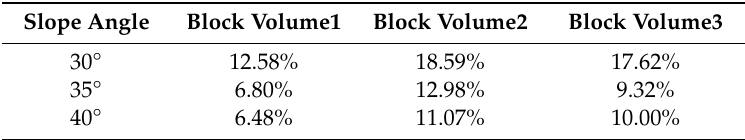
Table 3. Quantitative description of the e ff ect of multiple-surge impact on the spreading distance of debris